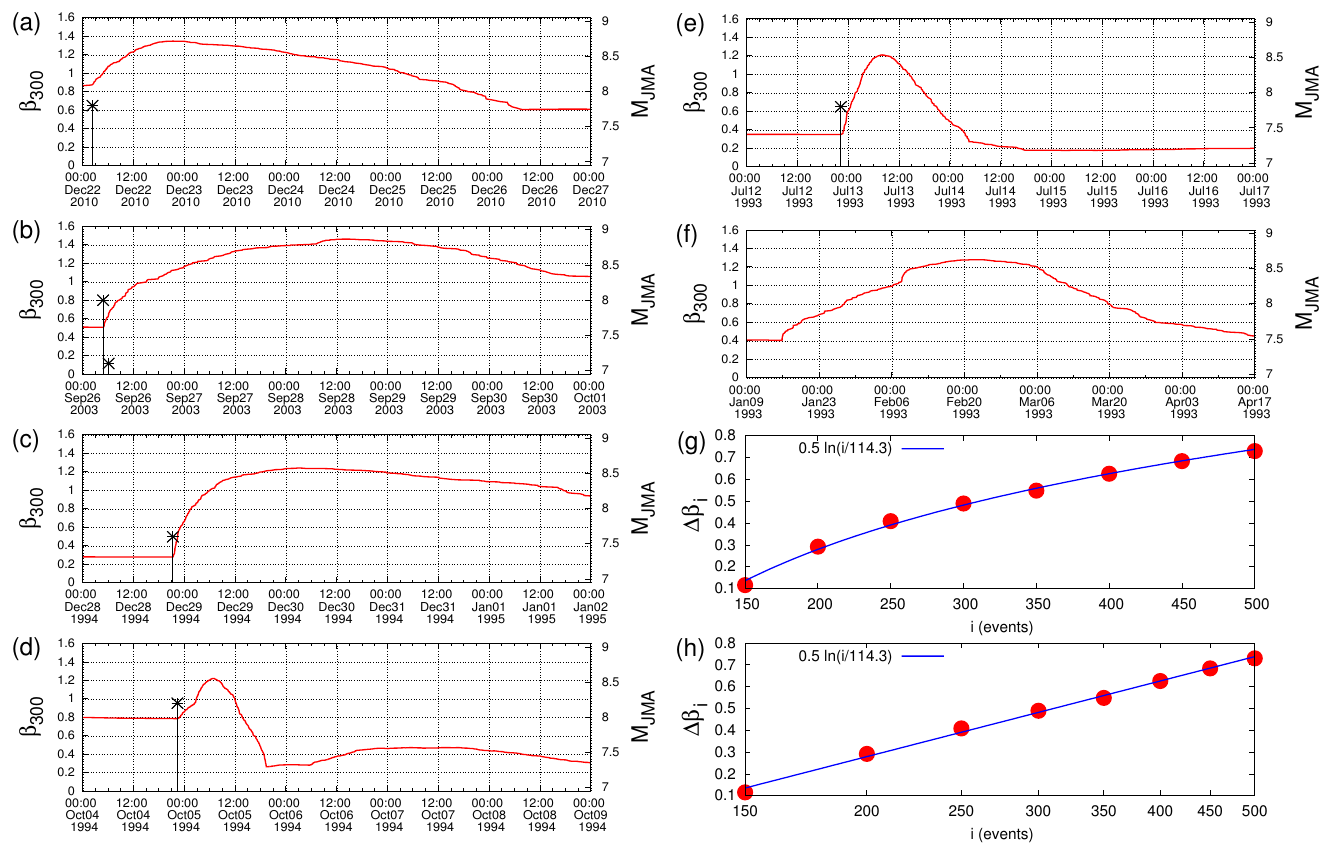
Figure 12. Excerpts of Figure 11 in expanded horizontal scale. ( a – e ): They show what happens upon the occurrence of each of the major ( M ≥ 7.6) shallow EQs in Japan from 1 January 1984 until the M 9 Tohoku EQ occurrence. ( f ): The change observed after the M 7.5 EQ (not shown since it is not shallow) on 15 January 1993. Panels ( g , h ) show the lin–lin and lin–log plots, respectively, of the interrelation ∆ β i = A ln ( i / B ) between the variation ∆ β i of the increase of β i upon M 7.8 EQ occurrence on 22 December 2010 versus the window length i , for i = 150–500 events. The least- squares fit results in A = 0.500 ± 0.012 and B = 114.3 ± 2.9 events. Taken from Ref. [71]. The EQ mangitudes M JMA are shown by black asterisks read in the right